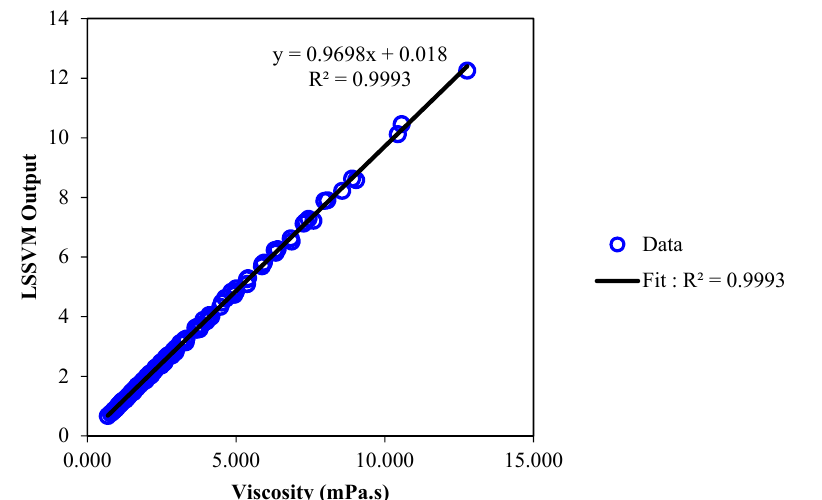
y = 0.9698x + 0.018 R² = 0.9993